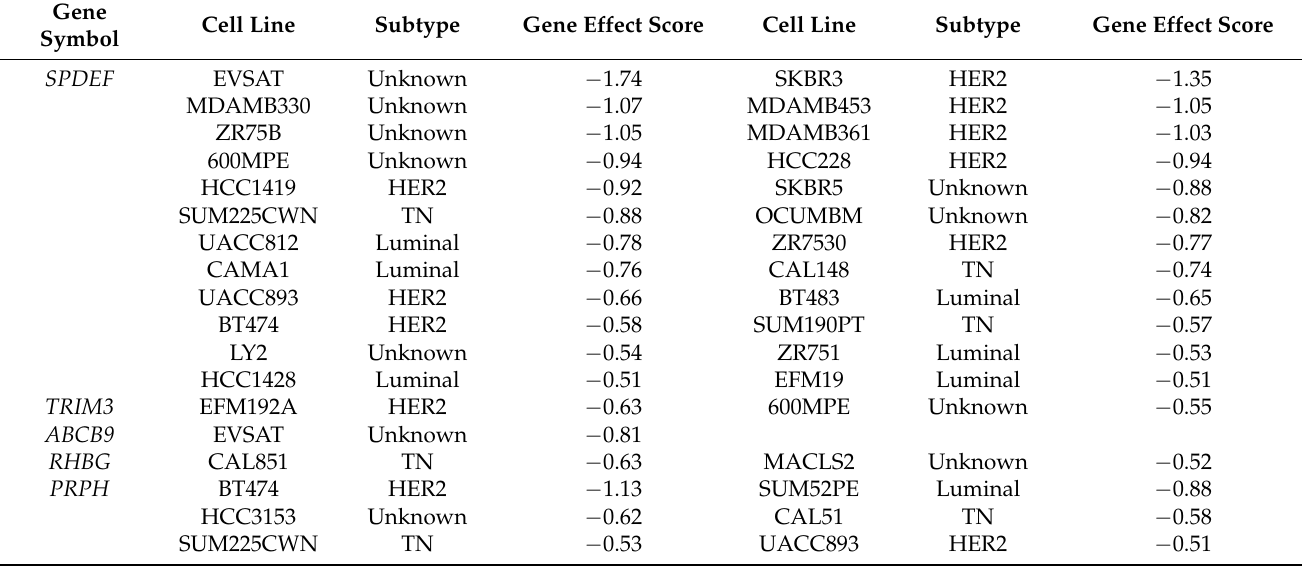
Table 3. Gene effect scores of RNAi (Achilles + DRIVE + Marcotte, DEMETER2). Gene